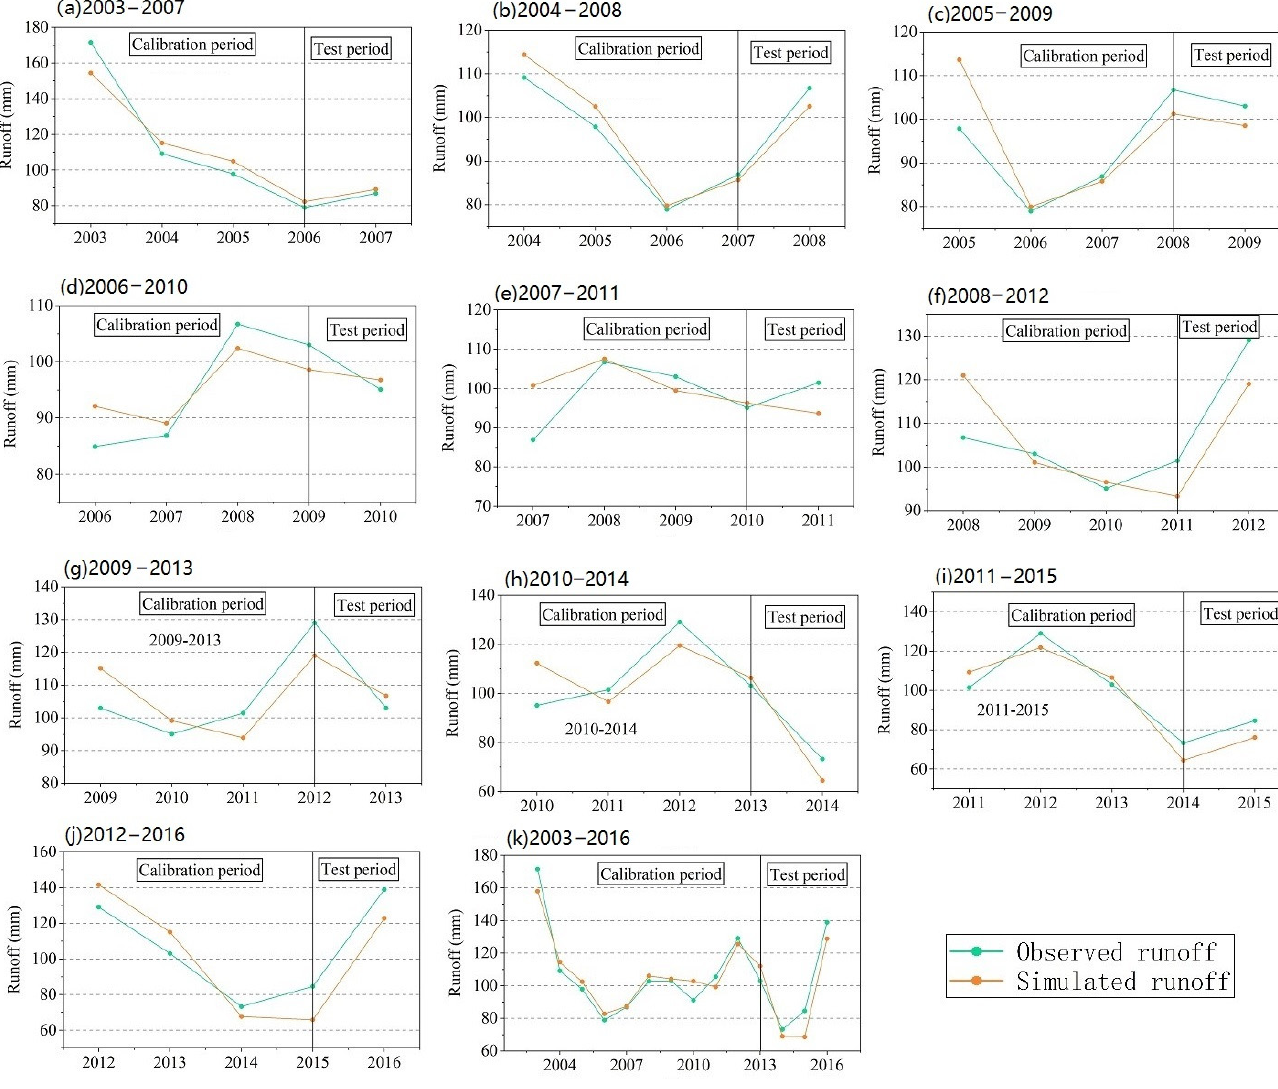
Figure 4. Runoff simulation by the VIC model both in the whole period ( k ) and the ten sliding window periods ( a – j ).